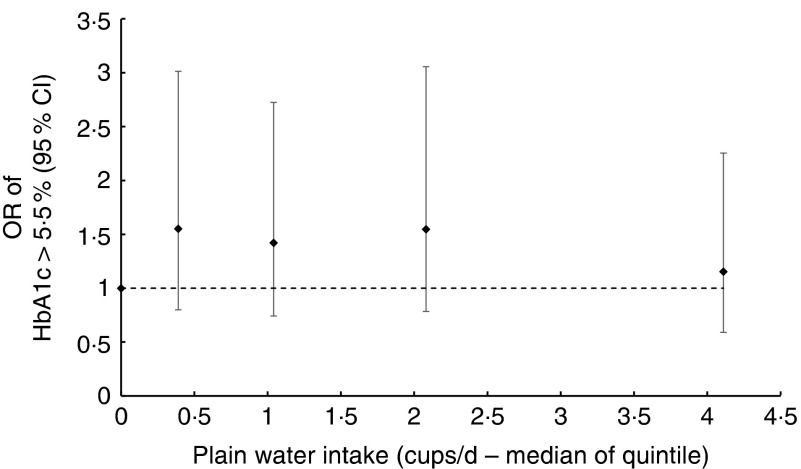
OR of glycated Hb (HbA1c) ≥5·5 % according to median plain water intake of each
quintile in women. The likelihood ratio test suggested no evidence of deviation from
linearity (P=0·451), calculated by comparing nested regression
models.